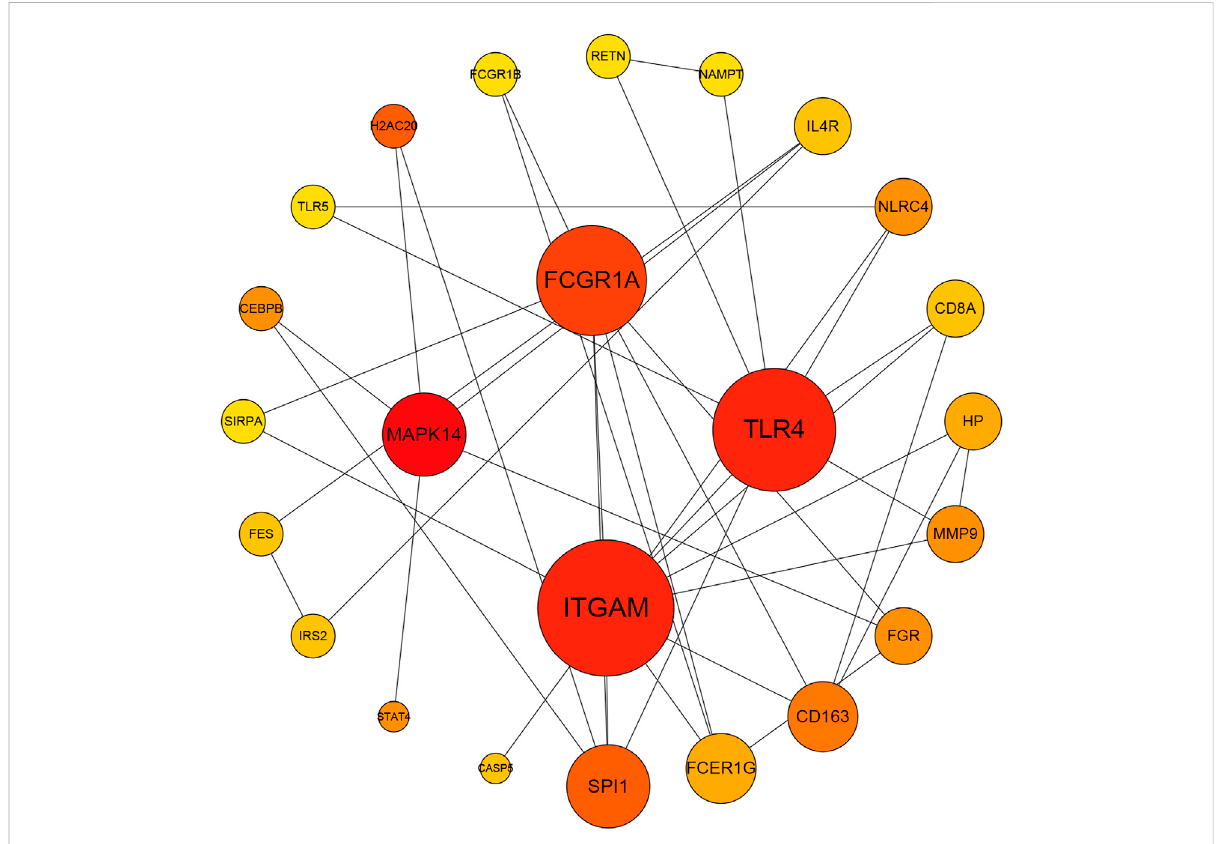
FIGURE 4 The Protein-protein interaction network of the overlapping genes between blue module and DEGs by Degree analysis. MAPK14, ITGAM, TLR4, and FCGR1A were calculated as the top four hub